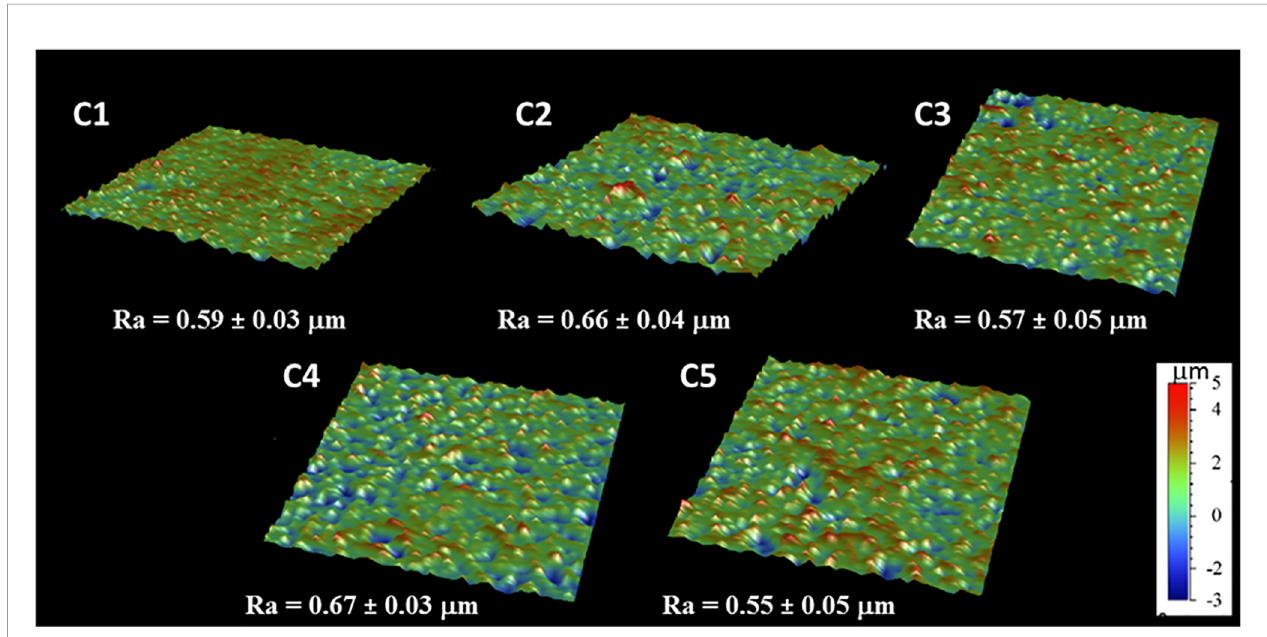
FIGURE 3 | Topographic maps for Ti6Al4V-DOPA and the different agarose-based coatings.